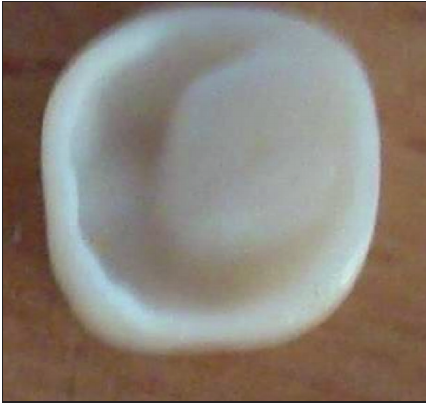
Figure 8: Tooth preparation for pressable ceramic endocrown.